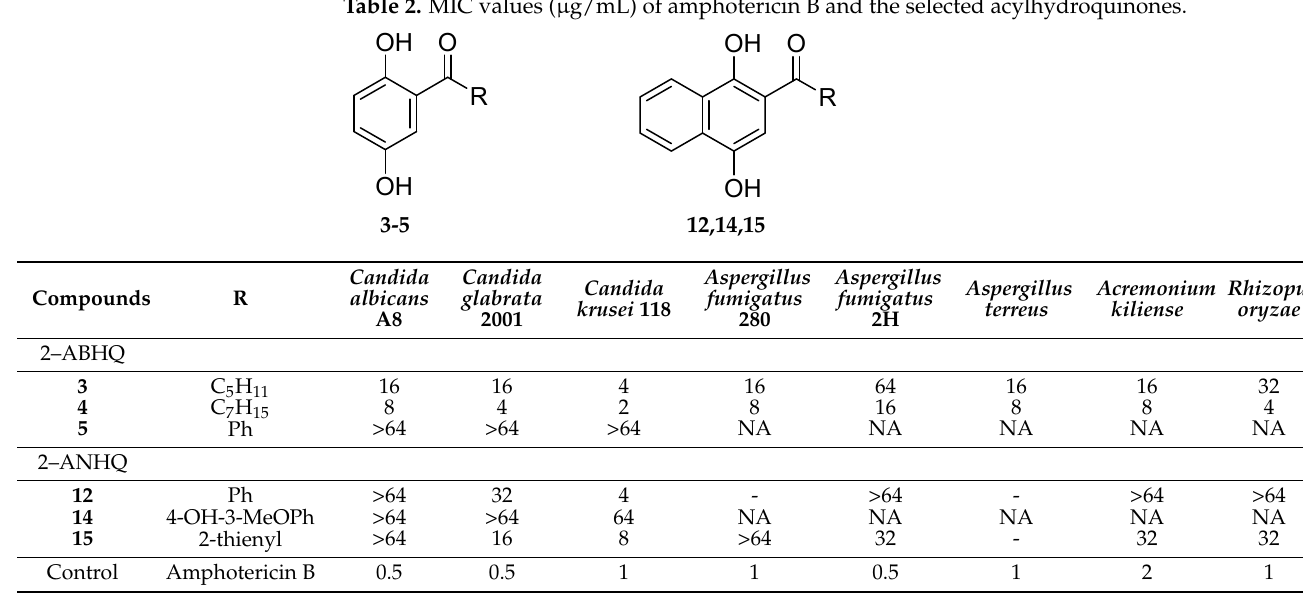
Table 3. Antioxidant activities of octanoylbenzohydroquinone 4.